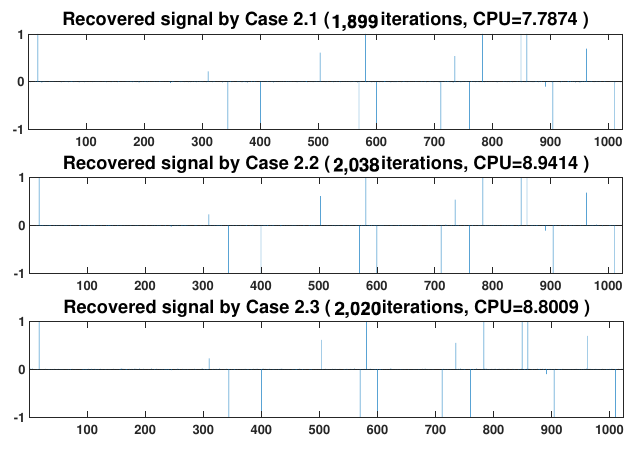
Figure 5. Recovered signal by Case 2.1, Case 2.2 and Case 2.3,